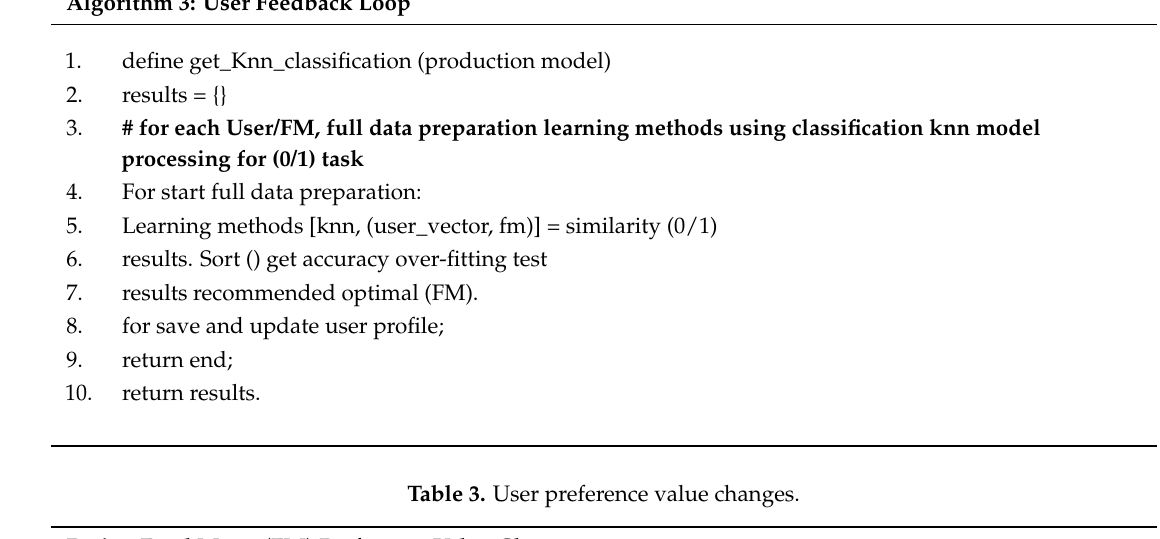
Algorithm 3: User Feedback Loop